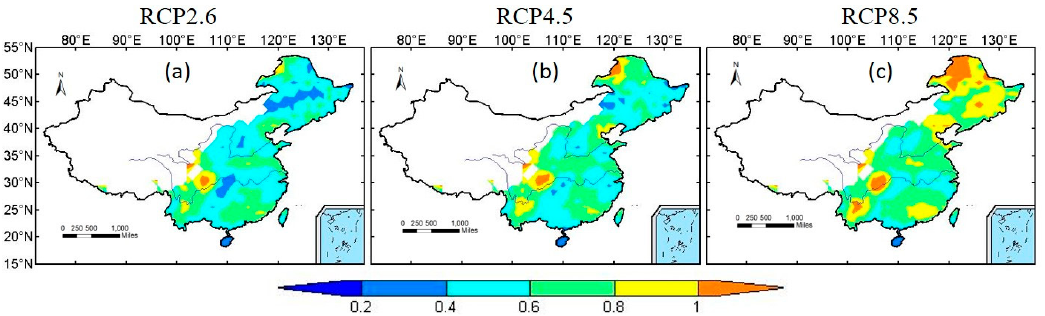
Figure 6. Coefficient of variation of flood prediction from 2011 to 2099. Figure 6. Coe ffi cient of variation of flood prediction from 2011 to